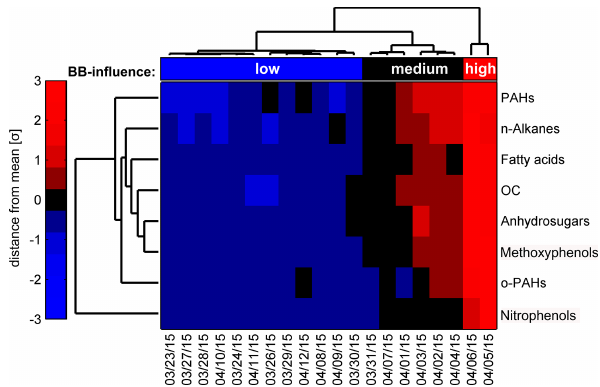
Figure 4. Clustergram based on organic composition of PM 2 . 5 sampled at PDI during the sampling campaign from 23 March to 12 April 2015. Dendrograms indicating organic compounds and OC can be seen at the top and sampling-day clustering on the left of the diagram. The color bar on the left indicates the shades associated with values in the cells and denotes the distance to the mean in mul- tiples of the standard deviation σ : dark to bright blue denotes the lower values, dark to bright red the higher values, and black refers to values closest to the